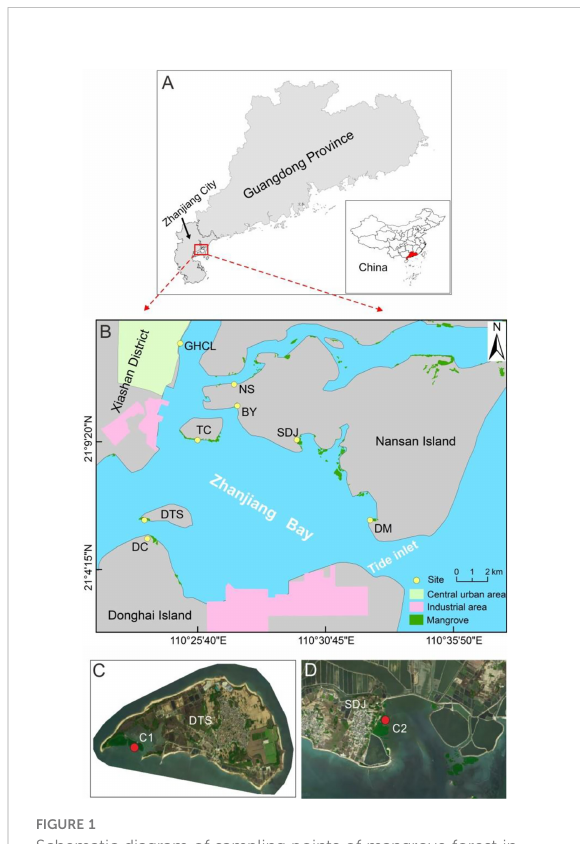
FIGURE 1 Schematic diagram of sampling points of mangrove forest in Zhanjiang Bay. (A) Location of Zhanjiang City in Guangdong Province; (B) Study area and sampling point location; (C) The location of C1 in Dongtoushan Island; (D) Location of C2 in the South Three